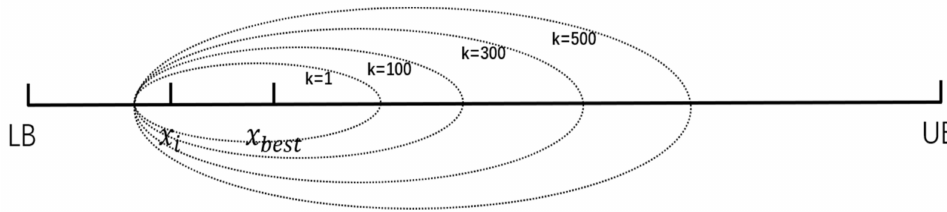
Figure 4. Adaptive relative reflection.